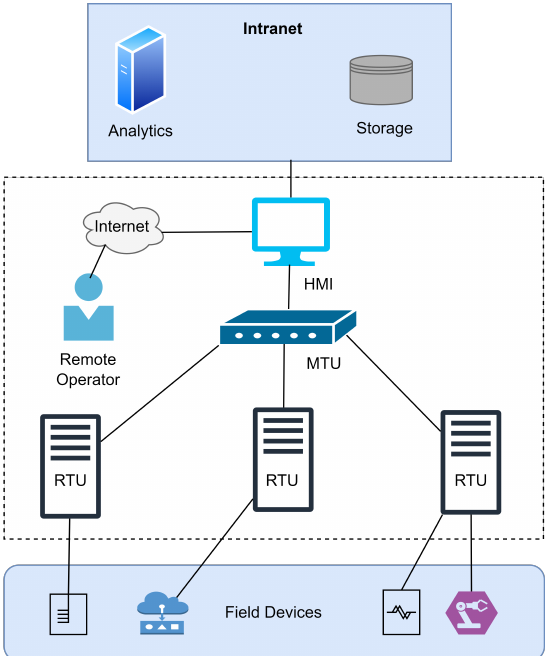
Figure 1. A naive architecture representation of SCADA network application with multiple control and monitoring